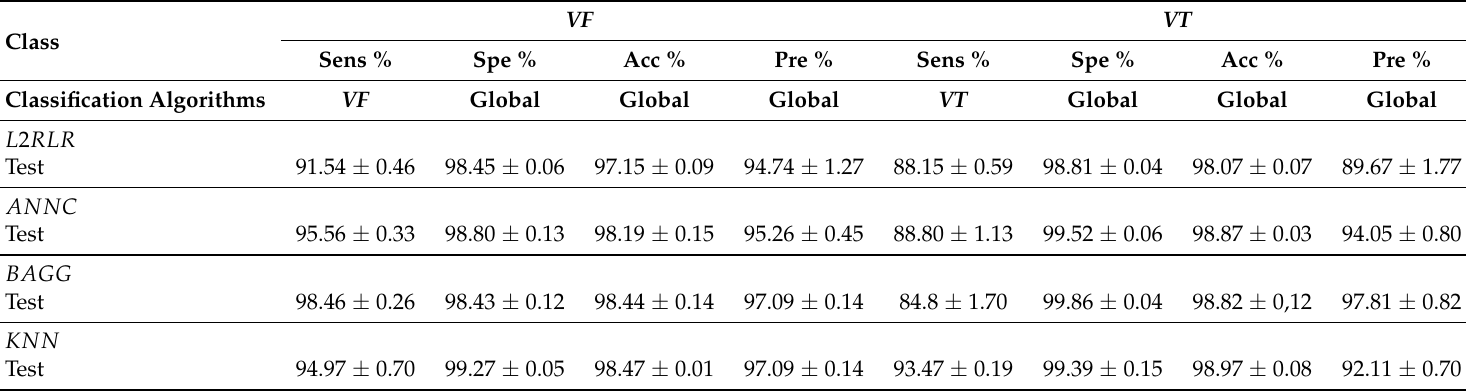
Table 1. Results for the different algorithms adaptive neural network ( ANNC ), Bagging ( BAGG ), L2 Regularization ( L 2 RLR ), and K-nearest neighbor ( KNN ) using as input the time-frequency representation image ( TFRI ) used to characterize and detect VF and VT classes.